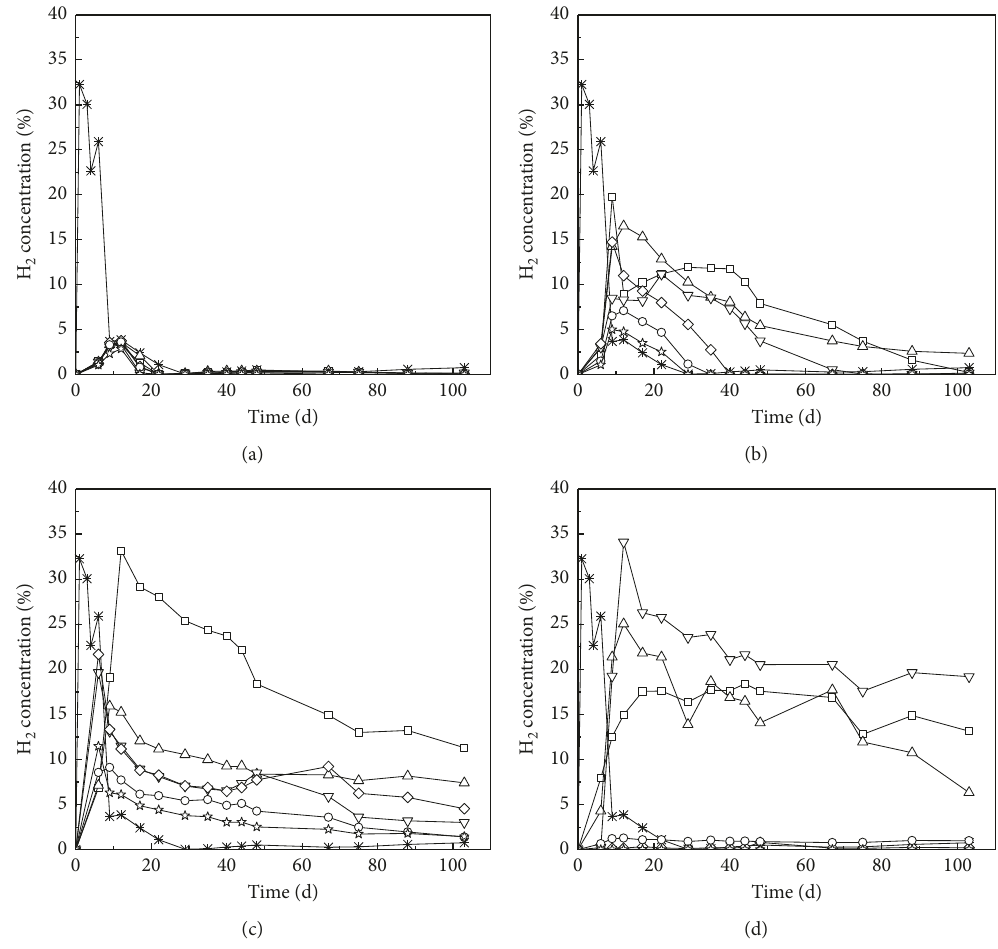
Figure 5: Changes in H 2 concentration with different iron sources. ( ∗ , Control; □ , 4000mg 24000mg · kg − 1 ; ○ , 32000mg · kg − 1 ; ☆ , 40000mg · kg − 1 ). (a) Fe 0 . (b) Fe 2 O 3 . (c) FeC 6 H 5 O 7 . (d) Fe 2 (SO 4 ) 3